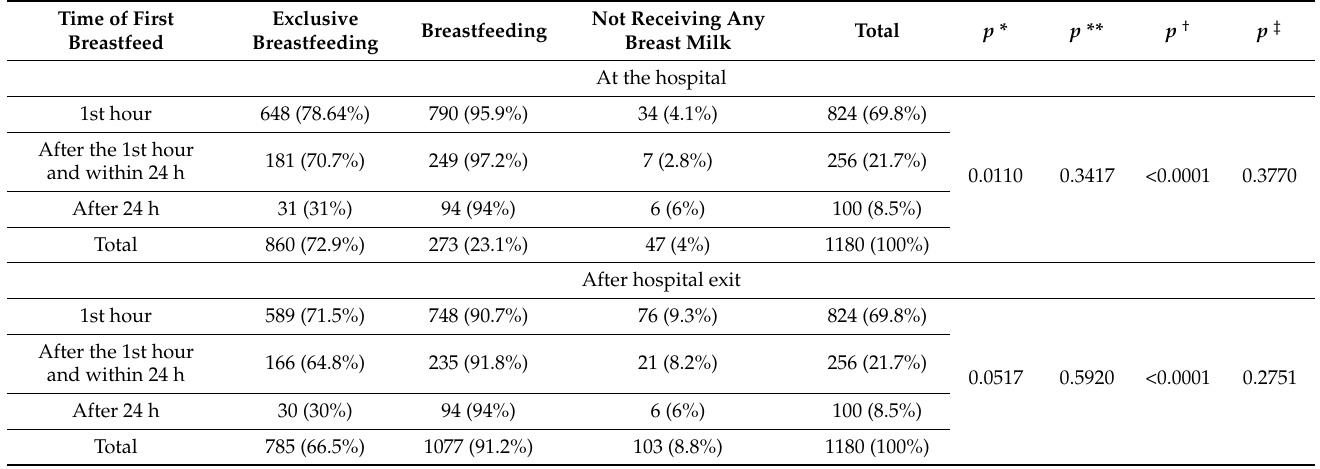
Table 4. The relationship between the time of the first breastfeeding and the rates of the exclusive breastfeeding, the breastfeeding and the infants who did not receive any breast milk by infants’